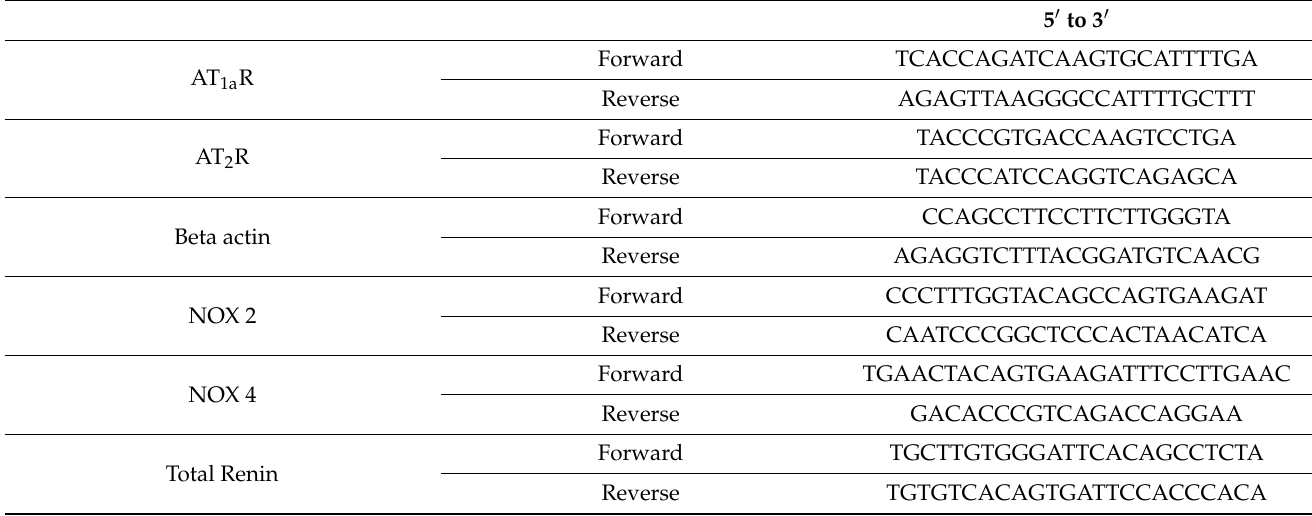
Table 1. Quantitative real-time PCR